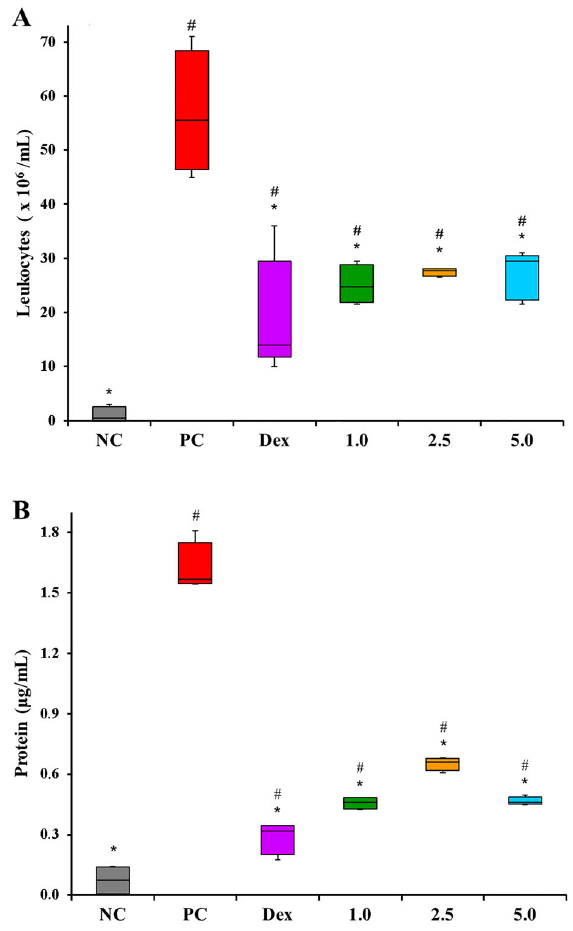
Figure 4. Effect of COPHCT in leukocyte migration ( A ) and extravasation of proteins ( B ) during the air pouch test induced by the subcutaneous injection of 1.0 mg/mL zymosan into the dorsal region of the mice. Central line: median; box: 1st and 3rd quartiles; whiskers: min and max values (5 animals per group). *P o 0.05 compared to the Positive Control group and # P o 0.05 compared to the Negative Control group, determined by Kruskal Wallis and Mann-Whitney U tests. Groups: NC (Negative Control: PBS, sc + PBS 10.0 mL/kg, ig ); PC (Positive Control: zymosan 1.0 mg/mL, sc + PBS 10.0 mL/kg, ig ); Dex (zymosan 1.0 mg/mL, sc + 2.0 mg/kg dexamethasone, ig ); 1.0, 2.5, and 5.0 (zymosan 1.0 mg/mL, sc + COPHCT 1.0, 2.5, and 5.0 mg/kg, ig